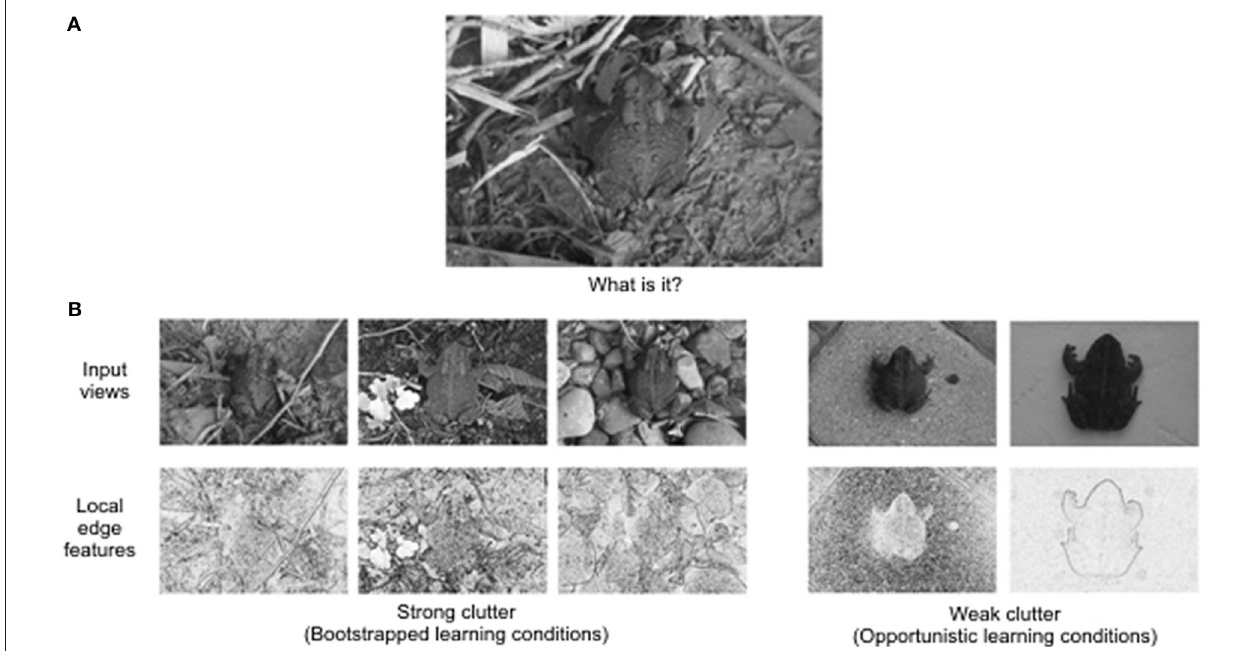
FIGURE 1 | Effect of prior knowledge on object recognition in clutter. (A) A novel image , i.e., a pattern of intensities whose pixel representation the reader has never seen before. Yet, the toad is easily detected and recognized as a familiar object. Local input information, such as might be extracted by oriented spatial filters in V1 (simple or complex cells) used for signaling local oriented edges, provide highly ambiguous information. In typical natural images, there is no local information that uniquely distinguishes which edges belong to the boundary of an object, and which do not. (B ) Different images of the same toad result in very different feature patterns. For example, it can be impossible to learn to distinguish which edge measurements near the boundary are from the toad vs. from the